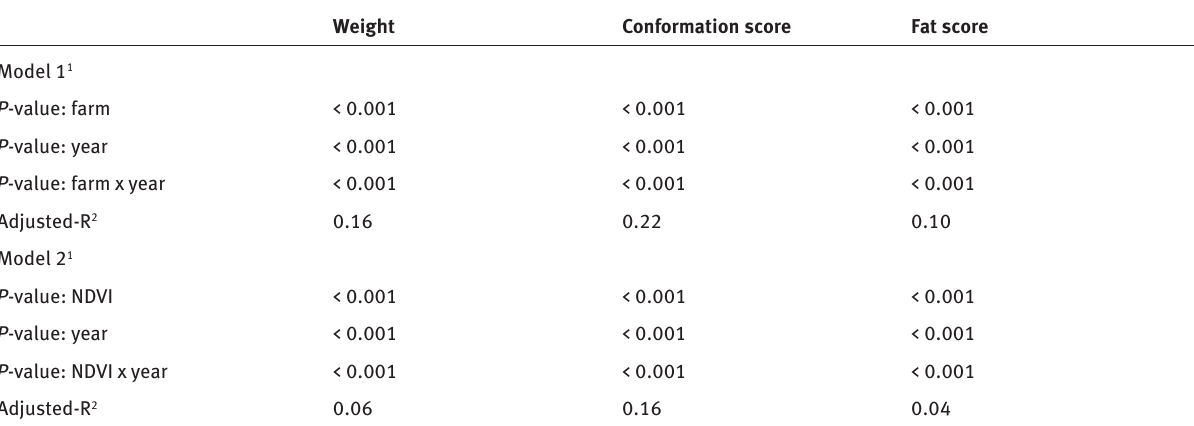
Table 5: The ability of farm, year and NDVI to explain variation in weight, conformation and fat score